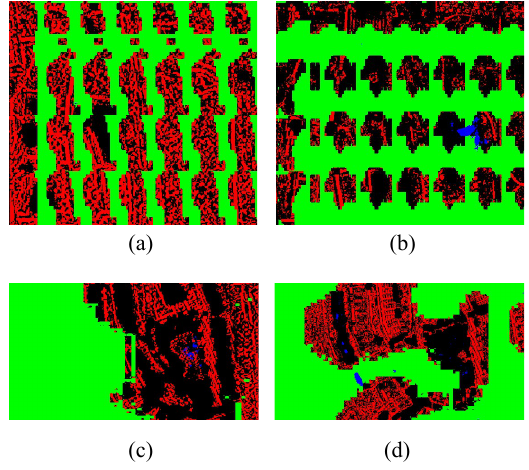
Figure 3. Red = buildings (Huang, Zhang, 2011; Huang al., 2017b), Green = Vegetation (Gupta et al., 2018), Blue = water (Tsikdogan et al., 2017; 2019), Black = Ground (e.g., soil and roads): Multiindex urban representation of (a) QuickBird image of “Scene 1” (b) WorldView image of “Scene 1” (c) QuickBird image of “Scene 2” (d) WorldView image of “Scene 2”.